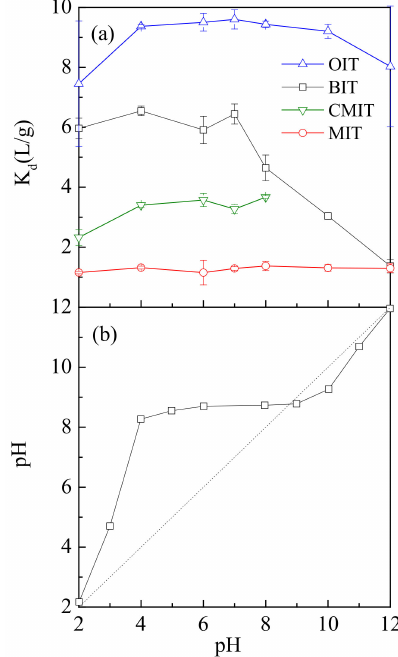
Figure 4. Effect of pH on the adsorption of isothiazolones onto 100 mg · L − 1 PAC dose ( a ) and determination of pH PZC ( b